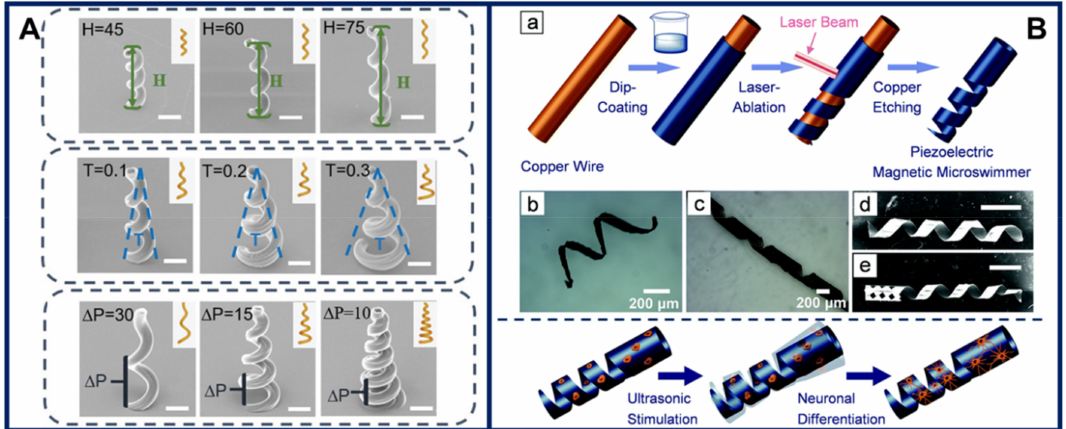
Figure 4. Recent examples of microswimmers developed for cell therapy. ( A ) Scanning electron micrographs of hollow microhelix magnetic microswimmers able to transport nanoparticles and cells. Scale bars, 20 µ m. Figure reproduced from [82], © 2019 WILEY-VCH Verlag GmbH & Co. ( B ) Piezoelectric magnetic microswimmers for cell di ff erentiation into neurons and subsequent delivery. Top: (a) fabrication steps. (b,c) Optical images of microswimmers with di ff erent design parameters. (d,e) Micrographs of microswimmers with and without a “head”. Bottom: cell culture and di ff erentiation schematics. Figurereproducedfrom[84], ©